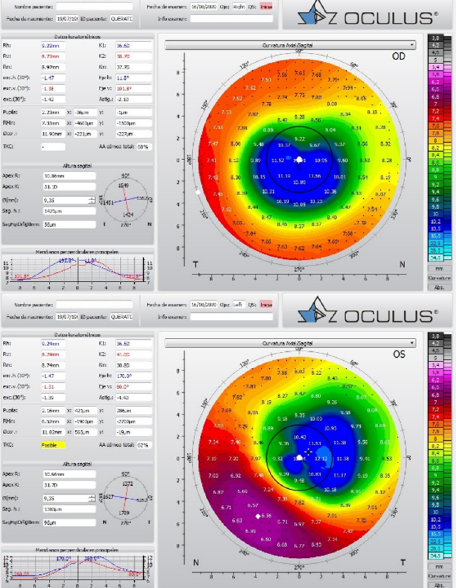
Figure 1. Corneal topography of both eyes measured with topographer. Right eye on the top and left eye on the bottom.